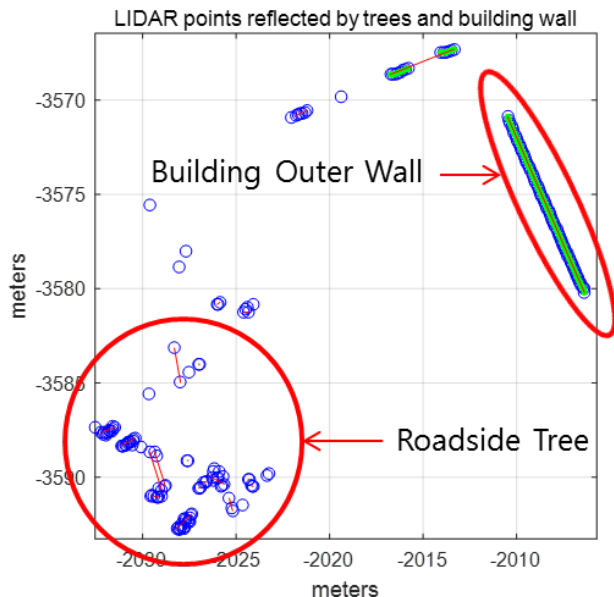
Figure 12. Light Detection and Ranging (LIDAR) points reflected by leaves of roadside trees and outer wall of building.